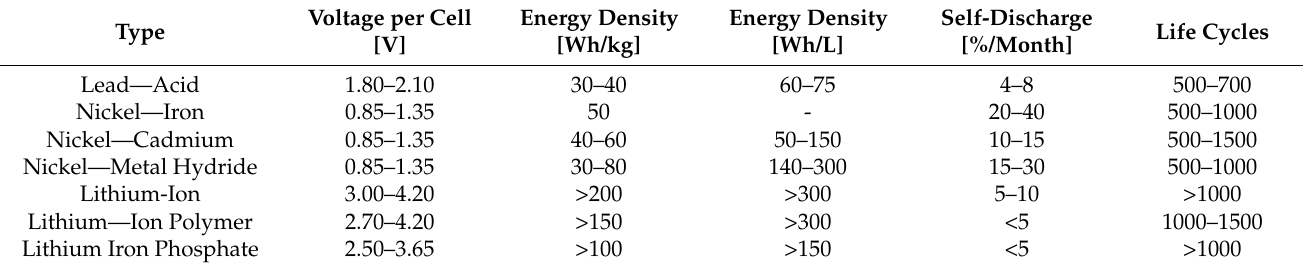
Table 2. Comparison of mainly used secondary batteries [5,22,25,26].